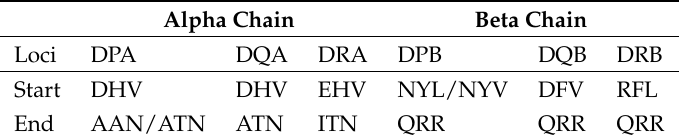
Table 5. Start and end markers to identify the polymorphic region of an